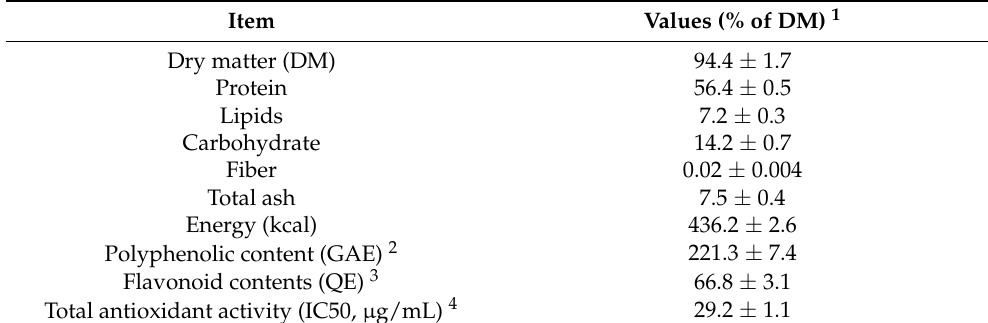
Table 1. The chemical analysis, polyphenols, flavonoids, and total antioxidant activity of the Spirulina platensis